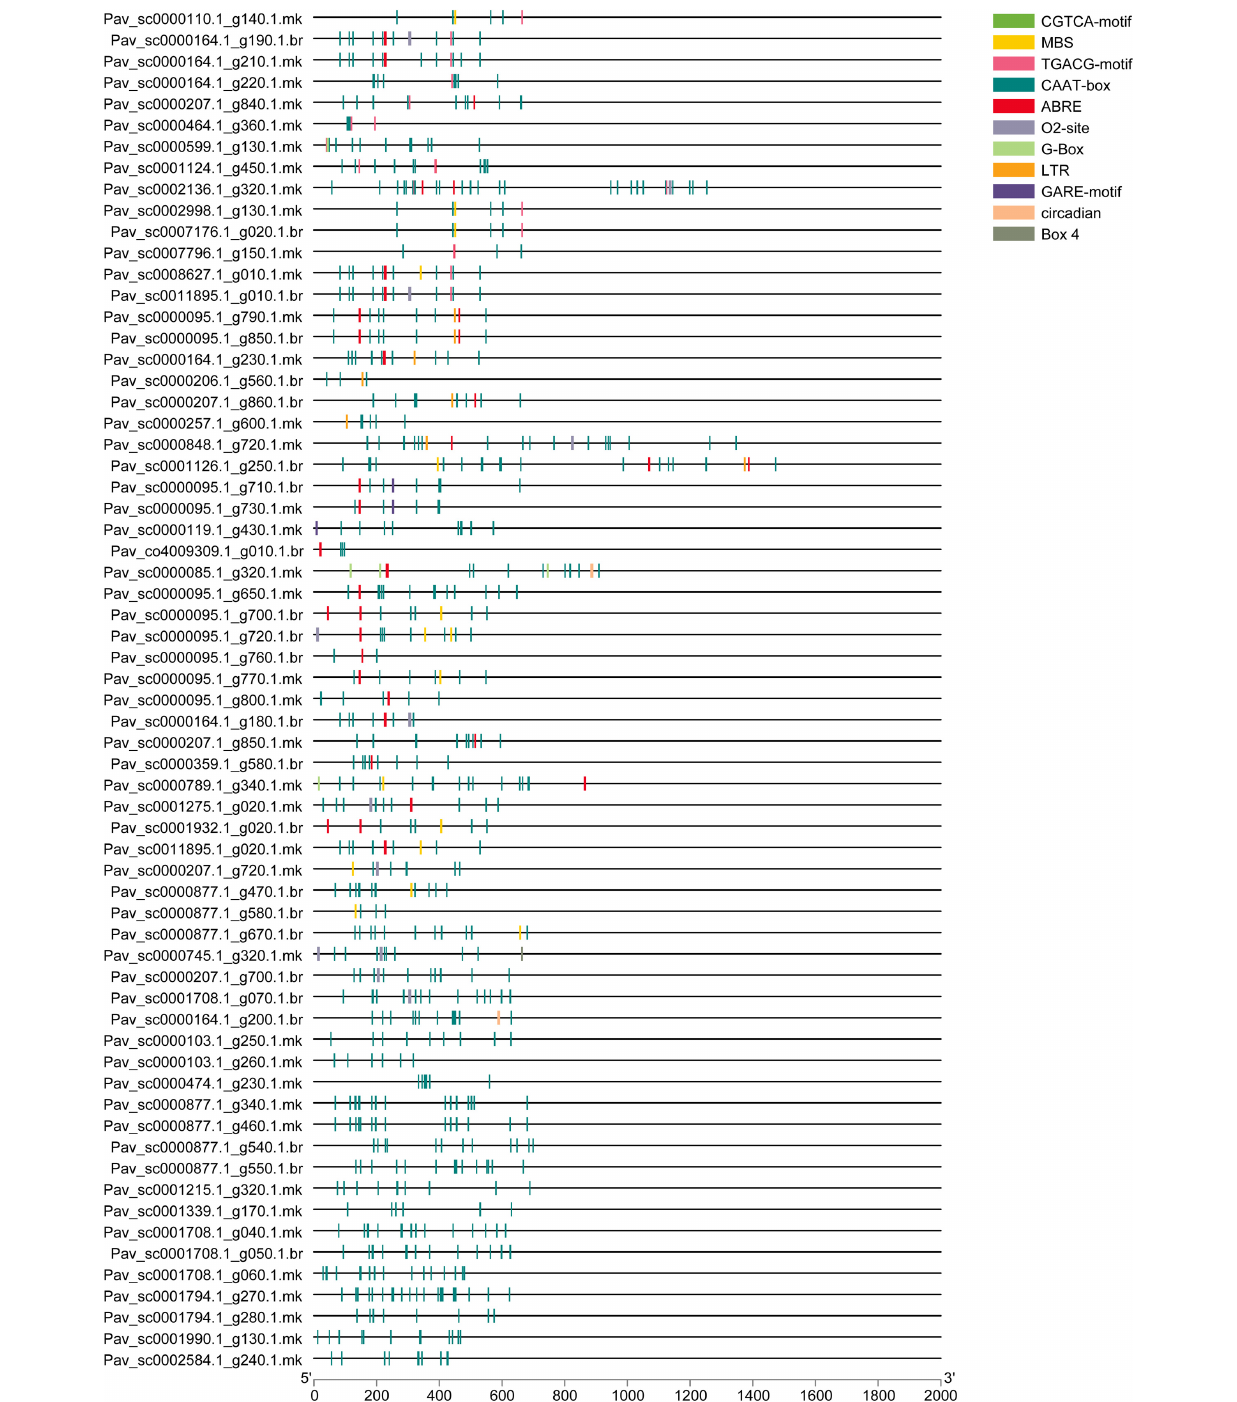
relationship among genomes of the Rosaceae species ( Figure 6 and Supplementary Table 4 ). These results illustrated that the sweet cherry genome and the other Rosaceae genomes have